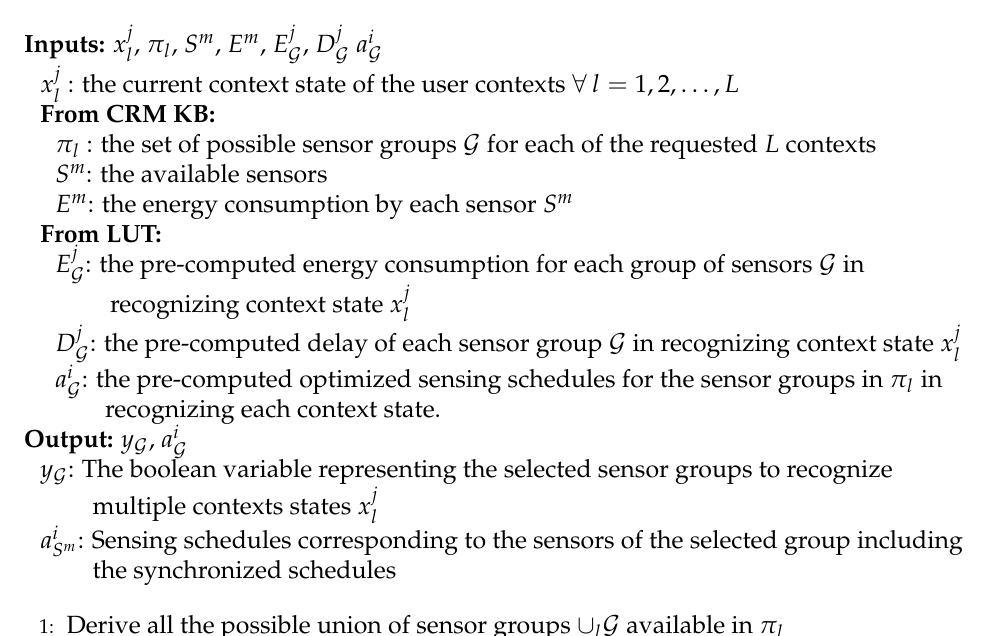
Algorithm 1, found on the following page, details the procedure for the online system that runs every time a context state changes, i.e., when the sensors’ latest measurements lead to a different inference than the state that was inferred from the previous measurements. The approach starts by computing combinations of sensor groups ∪ l G from the set of sensor groups π l capable of recognizing the desired contexts. For each possible sensor group combination ∪ l G , the sensing schedules are extracted from the LUT for each sensor group G . The sensing schedules are then synchronized for sensors that are common across multiple sensor groups. Algorithm 1 Online algorithm for sensor selection with sensing